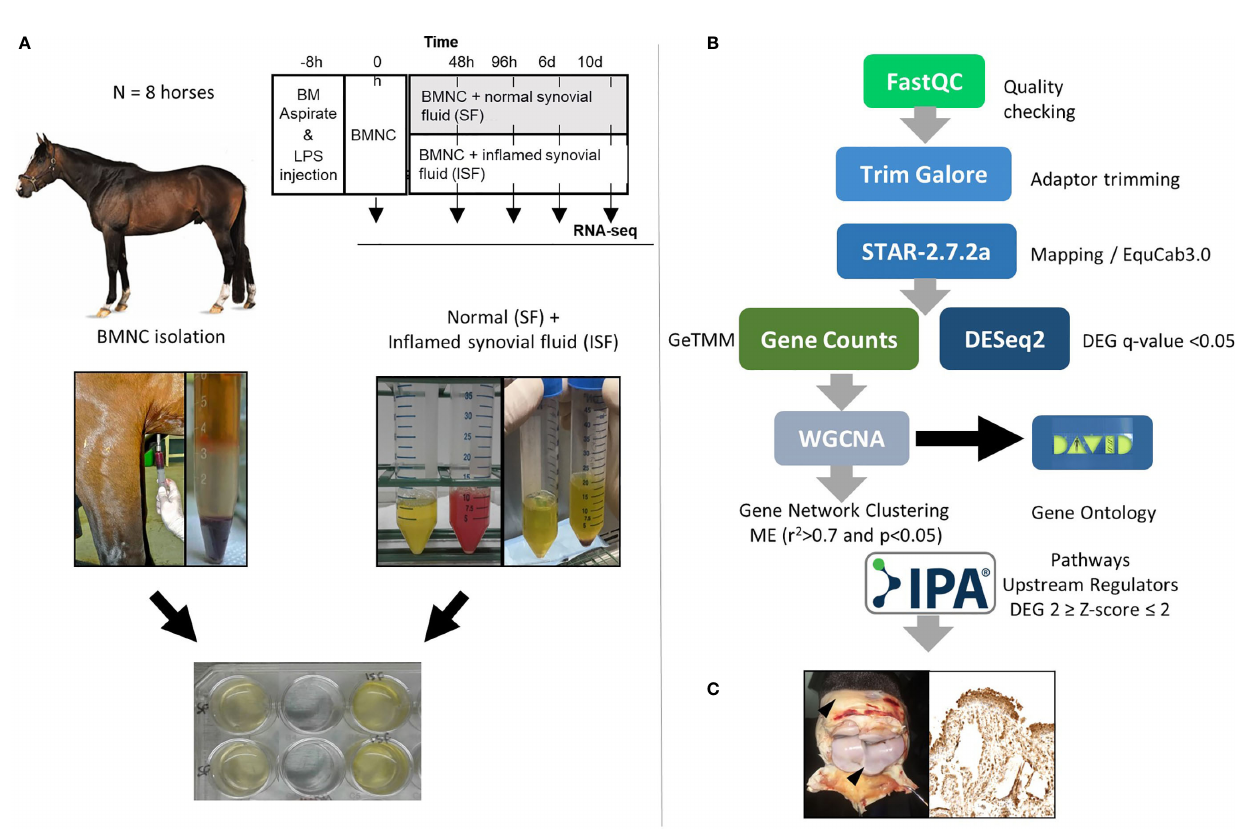
FIGURE 1 | (A) Study design showing timing of bone marrow aspiration and induction of synovitis (LPS, 0.5 ng/joint) (top). Harvesting and processing of bone marrow for BMNC isolation, and normal (SF) and in fl amed synovial fl uid (ISF) (middle) for cell culture following depletion of native SF cells (bottom). (B) Bioinformatics pipeline used for RNA-sequencing, quanti fi cation and analysis. (C) Immunohistochemical assessment of the synovium of in fl amed joints treated with BMNC leading to in fl ammation resolution or DPBS as a control for the expression of genes identi fi ed as upstream regulators or key in activated